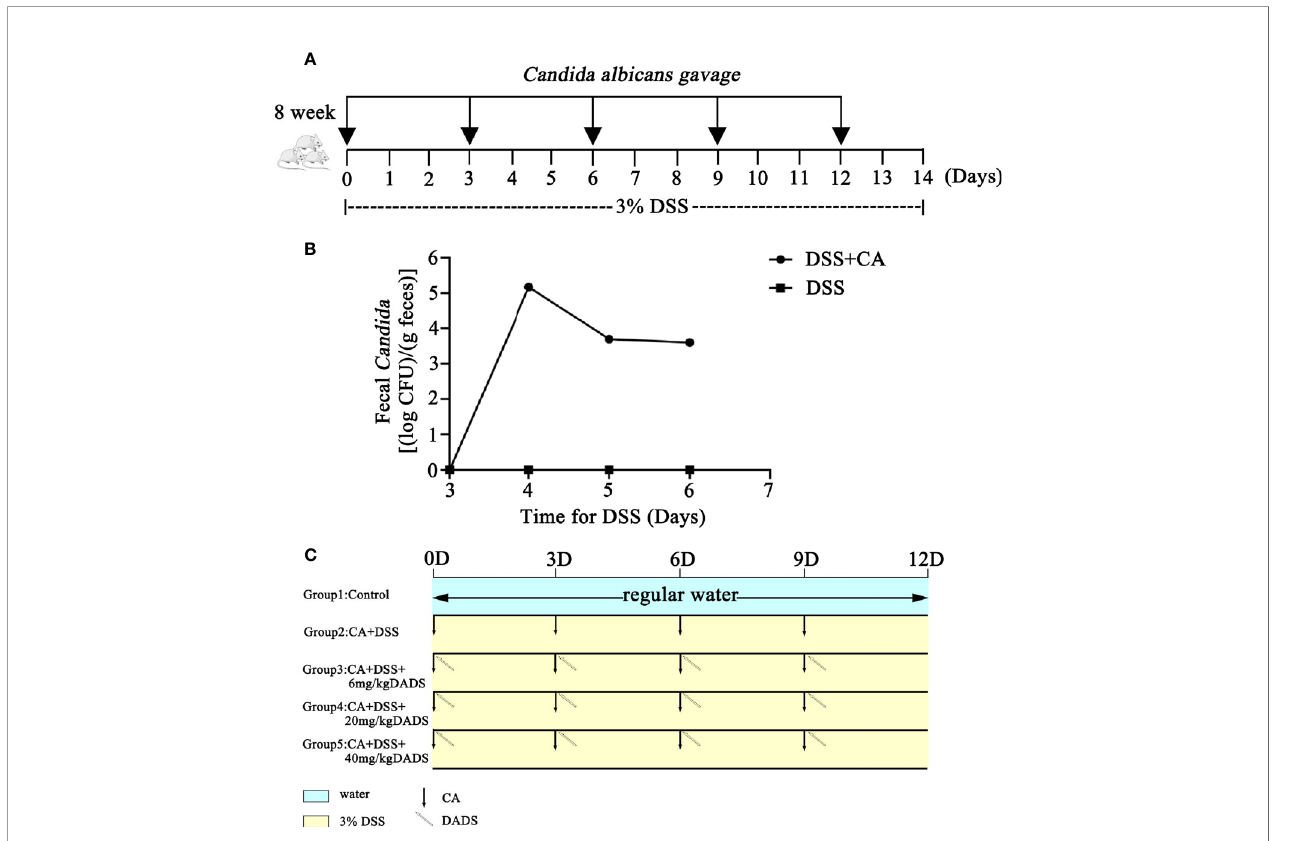
FIGURE 1 | Schematic of the animal experiment design, including C. albicans gavage and DADS administration. (A) Schematic of C. albicans infection in the animal models. (B) Fungal burden in feces. (C) Schematic diagram of the experiment to compare the function of different concentrations of